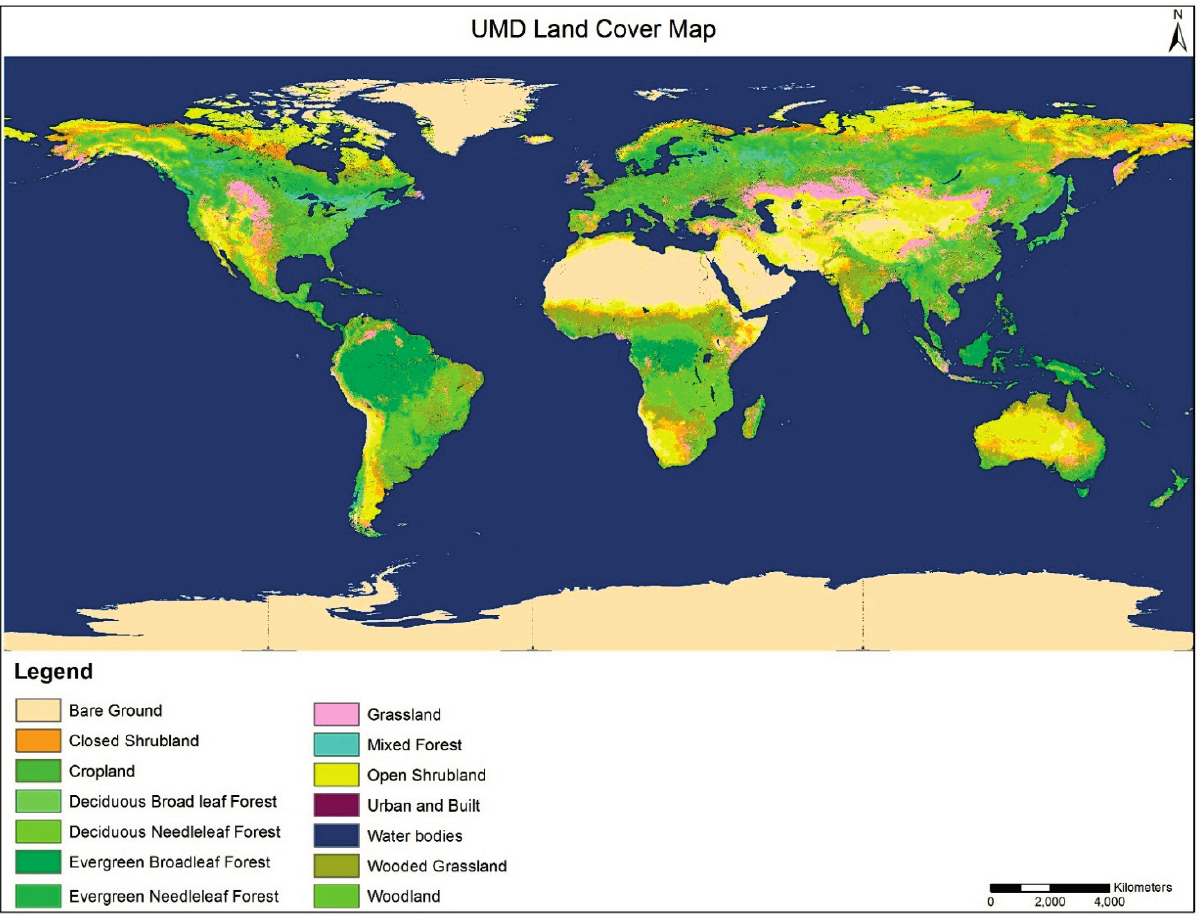
Figure 2. The UMD Land Cover Map (figure generated from data obtained at